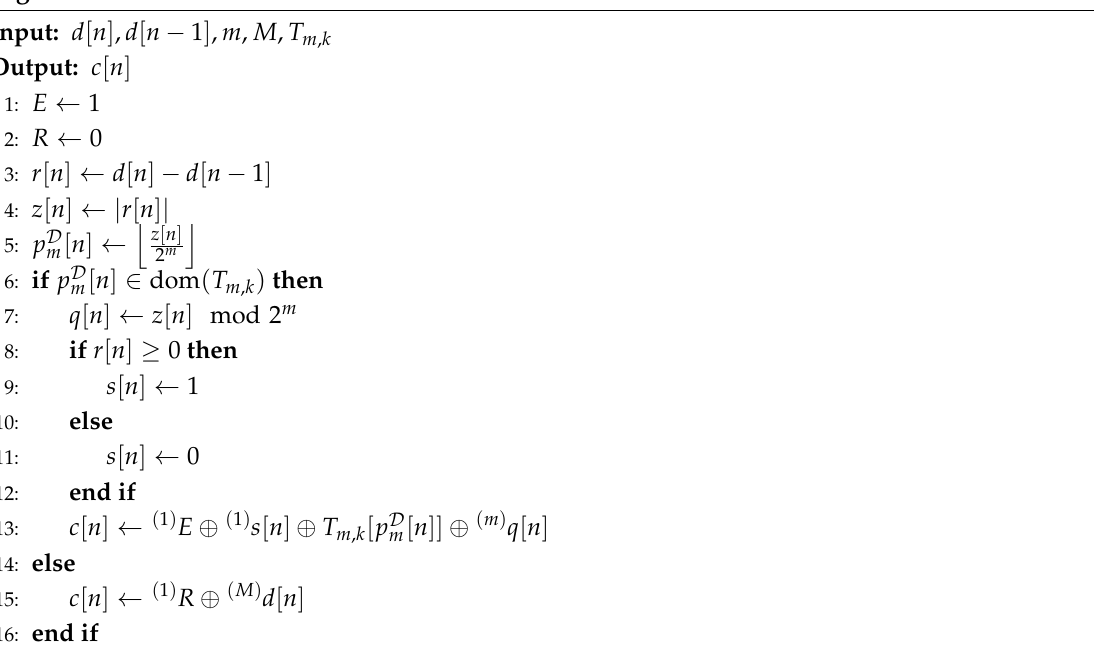
Algorithm 1 encode.